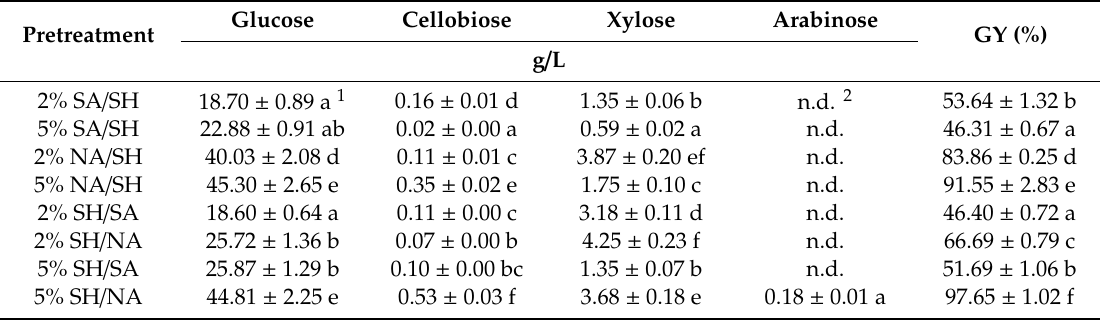
Table 4. The concentration of glucose, xylose, arabinose and cellobiose (g / L) in hydrolysates and glucose yield (%) after hydrolysis of two-stage pretreated JAS. Pretreatment